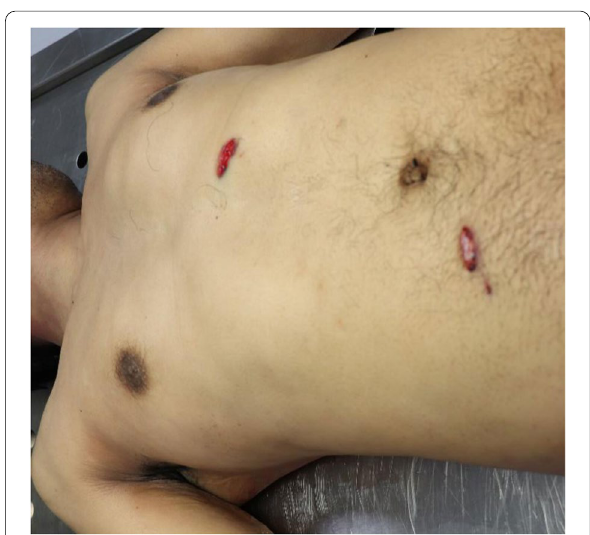
Fig. 2 The location of the chest and abdominal stab wounds where the upper one was present in the left lower region of the chest, measuring 2.7cm in length, while the lower one was present in the right lumbar region of the abdomen, measuring 2.5cm in